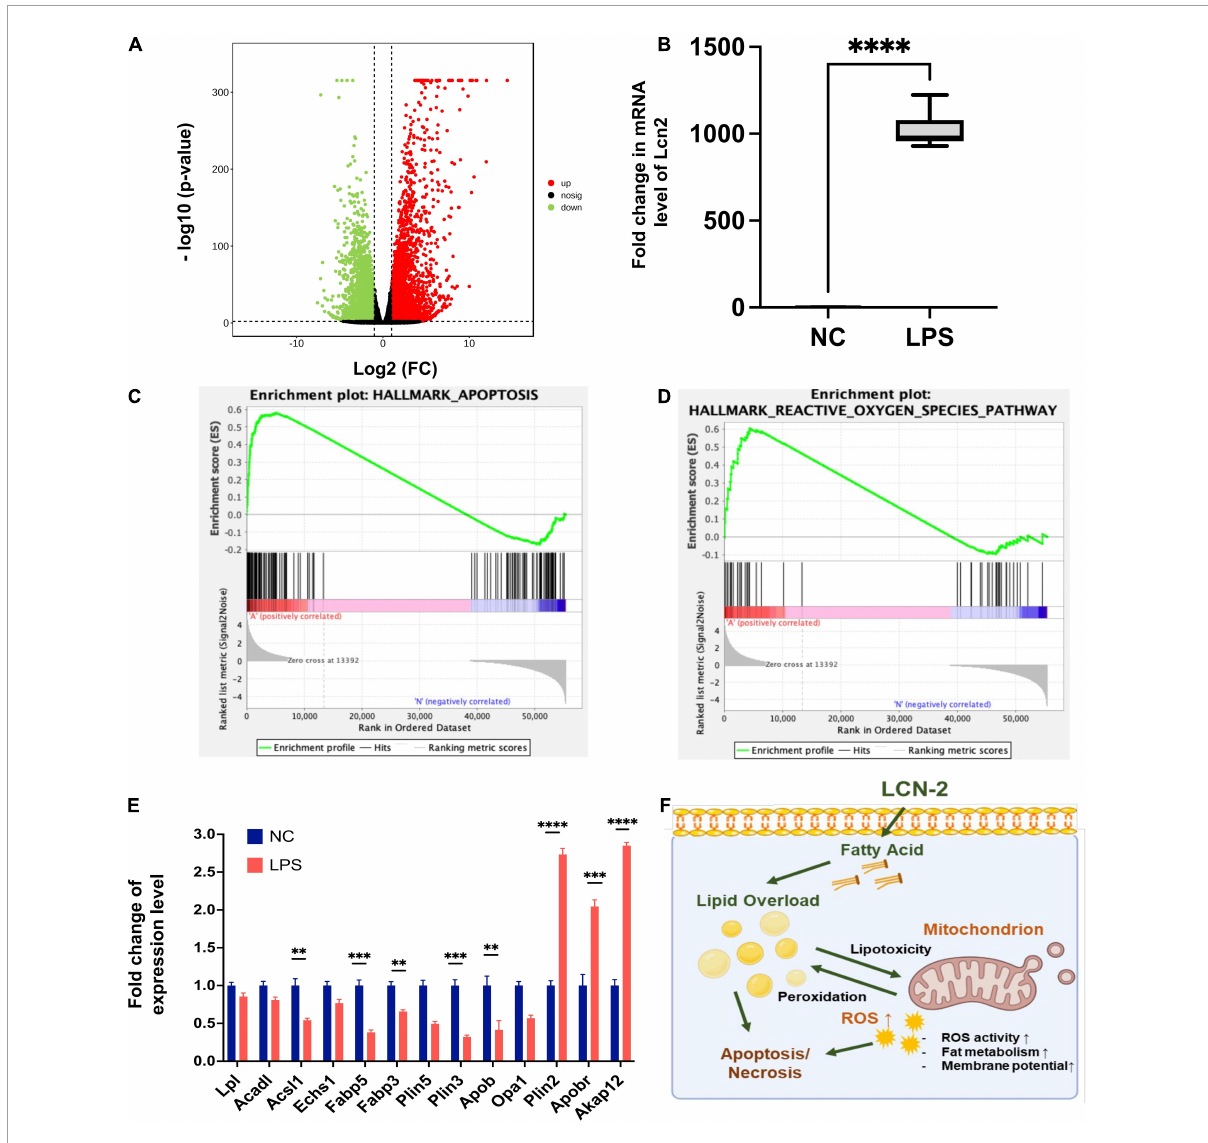
FIGURE4 (A) Volcano plot of DGEs of mouse myocardial tissue between groups by RNA sequence at 12 h after LPS stimulation. (B) Fold change level of LCN-2 in myocardial tissue. (C,D) GSEA analysis for function enrichment grouped by the high or low level of LCN-2 in the RNA-sequence analysis. (E) Molecules related to fatty acid uptake and β -oxidation changing obviously in LPS group. (F) Possible mechanism by which LCN-2 participates in septic myocardial injury via lipid metabolism disorder and mitochondrial dysfunction. ** P < 0.01, *** P < 0.001, and **** P <